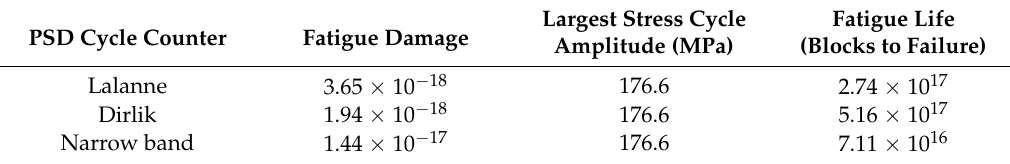
Table 6. Fatigue life using absolute maximum principal stress under highway road excitation.